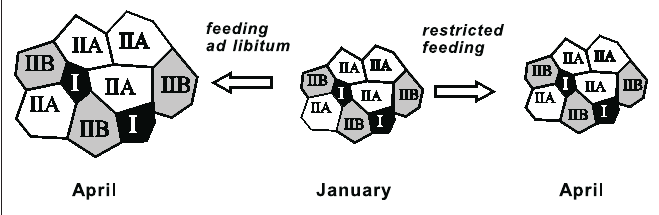
Fig. 5. Changes in cross sectional area in the middle gluteal muscle in reindeer calves. One group of calves was fed a pelleted feed ad libitum and the other group was fed lichens at 60% level of ad libitum